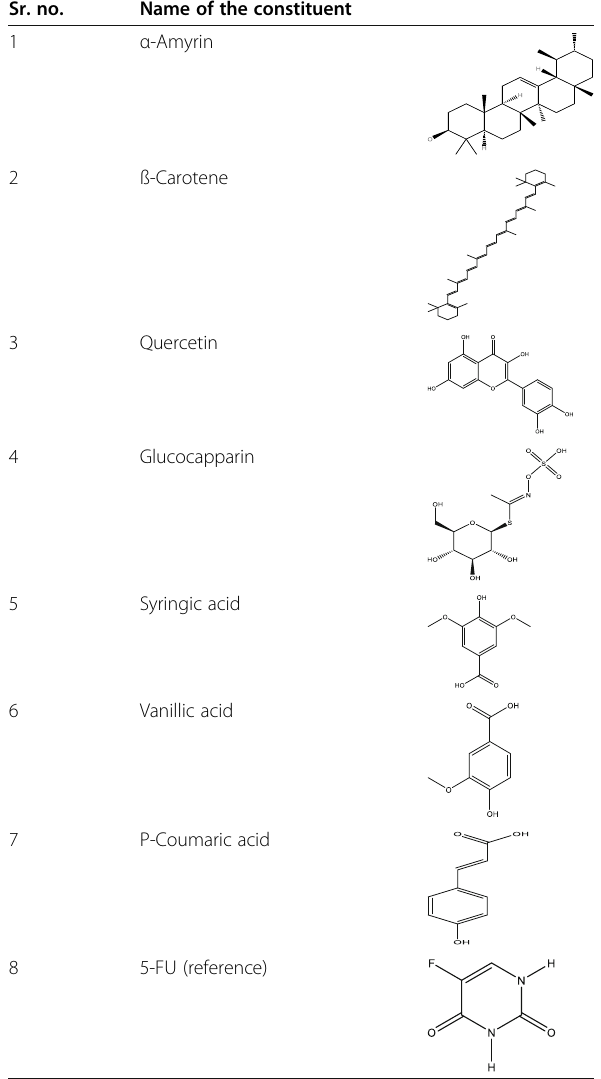
Table 3 Structures of some of the constituents found in